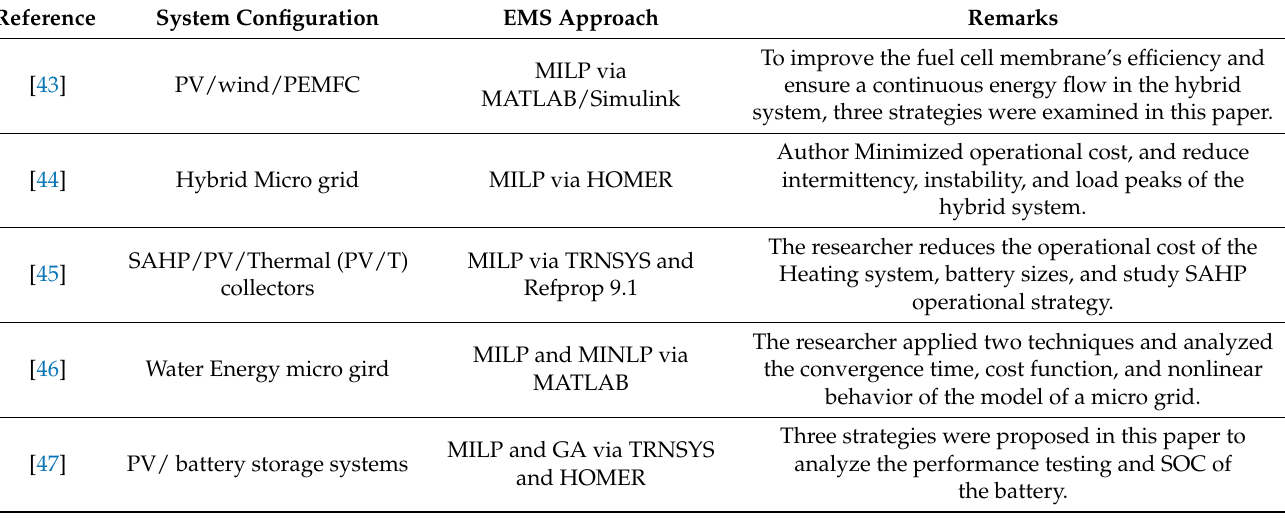
Table 1. Summary of recent studies of EMS based on linear/nonlinear